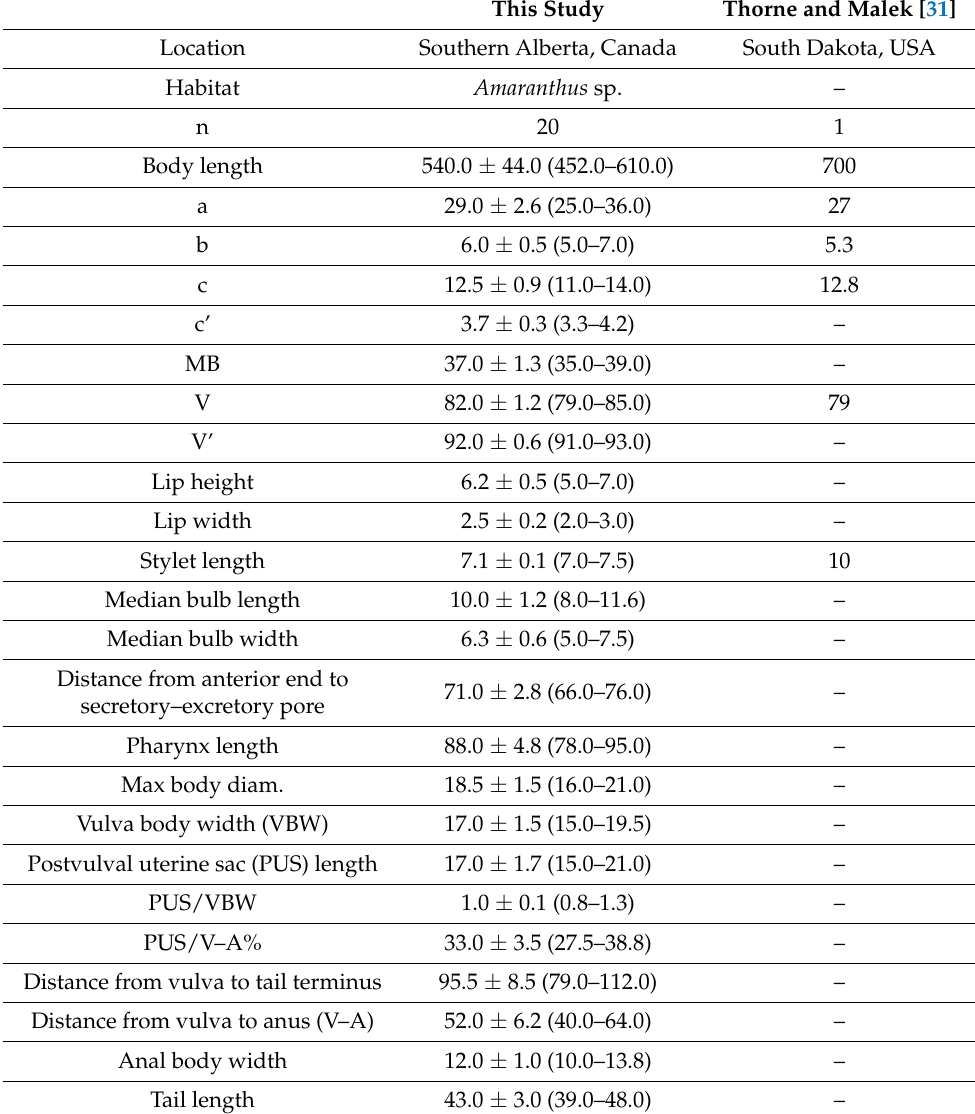
Table 2. Comparative morphometrics of female Ditylenchus clarus Thorne and Malek [31] reported in this study and in the original description. All measurements are in µ m and in the form: mean ± standard deviation (range) (southern Alberta) or mean (South